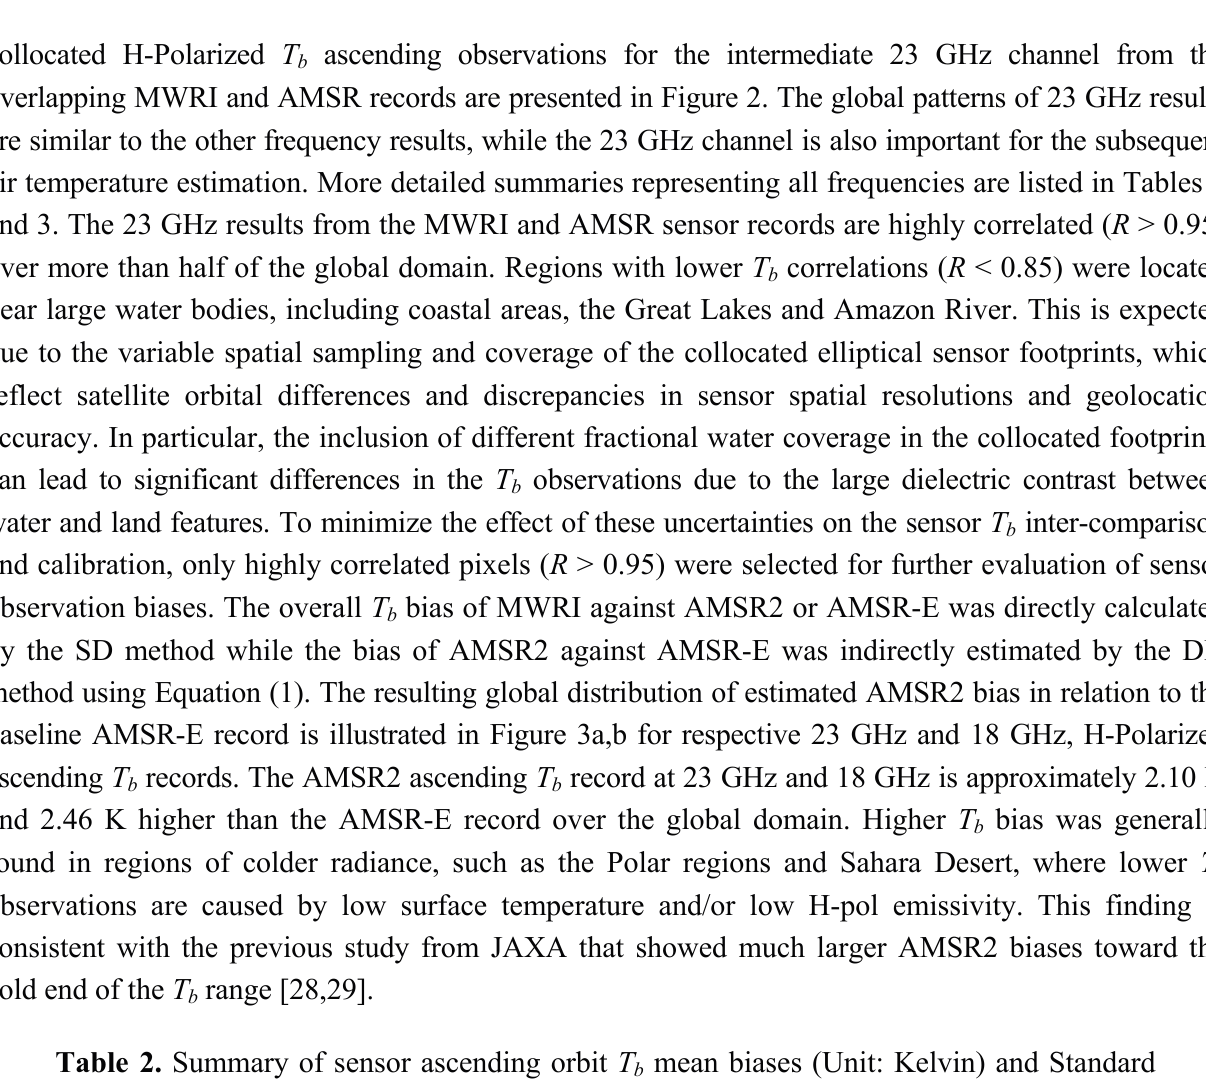
mean biases (Unit: Kelvin) and Standard b